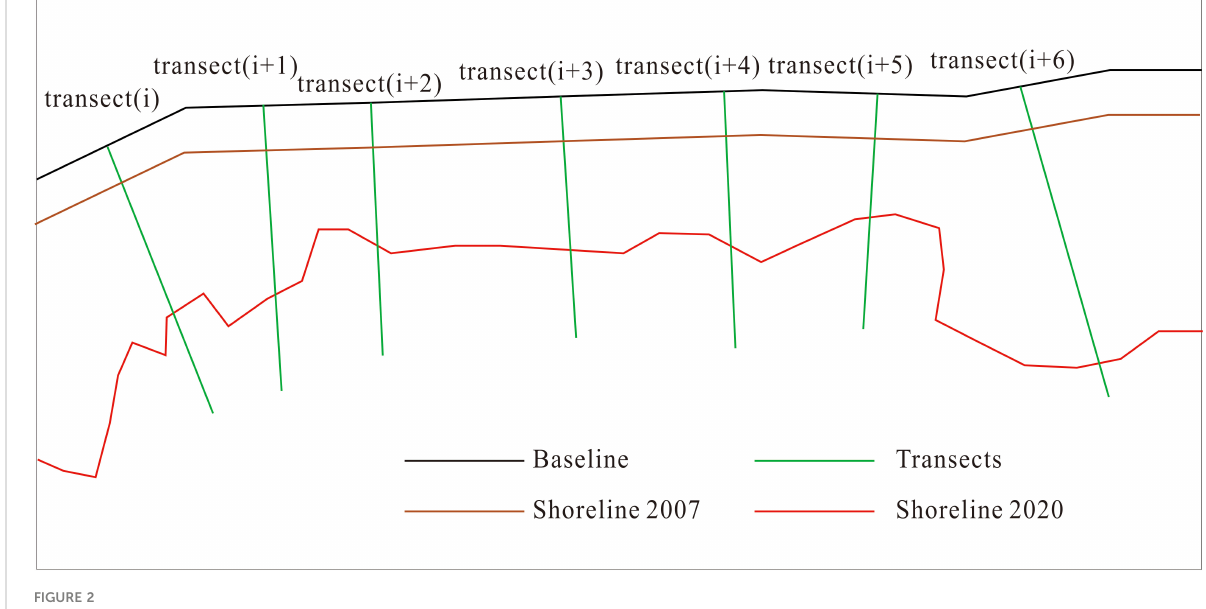
FIGURE 2 Schema of the analysis of shoreline change by baseline